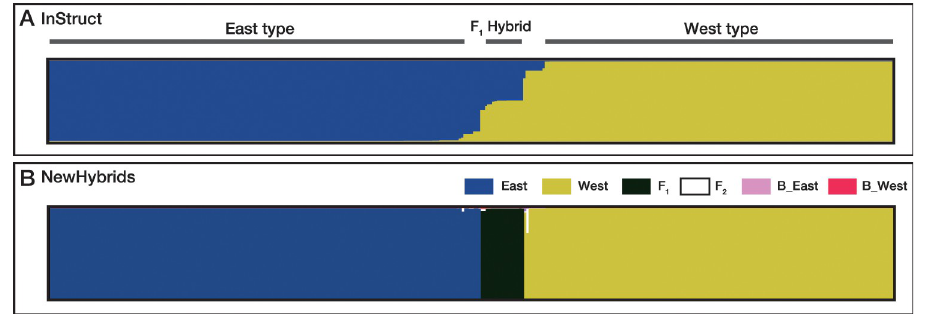
Fig 3. Identification and classification of non-admixed individuals (pure strains) and admixed individuals (hybrids) based on InStruct (A) and NewHybrid (B).